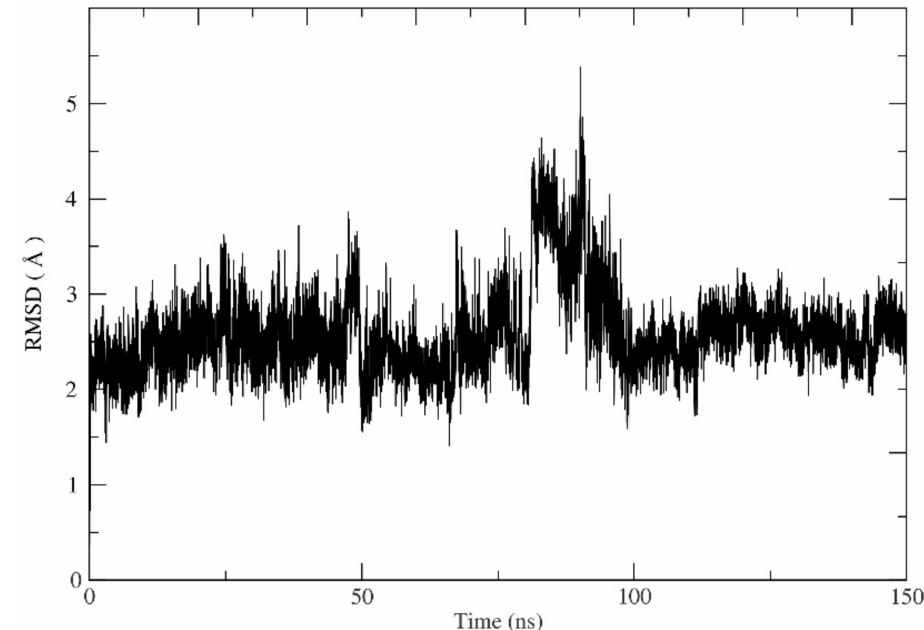
Figure 7. Root-mean-square deviation (RMSD) of ligand heavy atoms after least-square fitting to backbone confirmations of protein-ligand complexes during 150 ns.